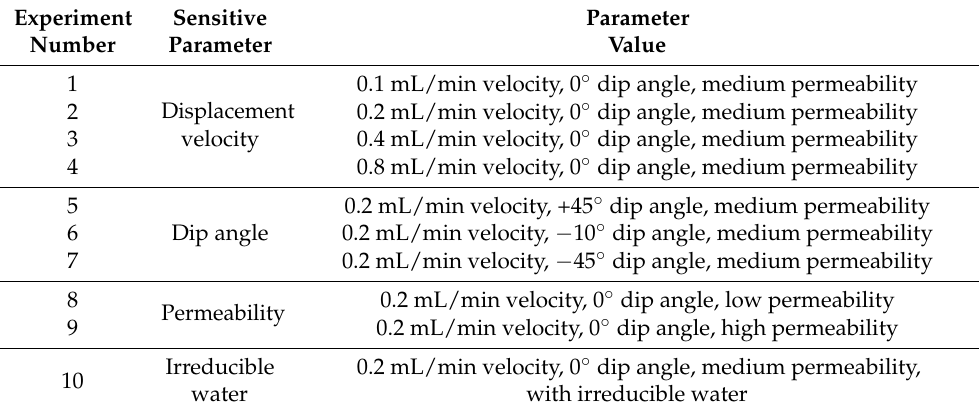
Table 5. Experimental design.